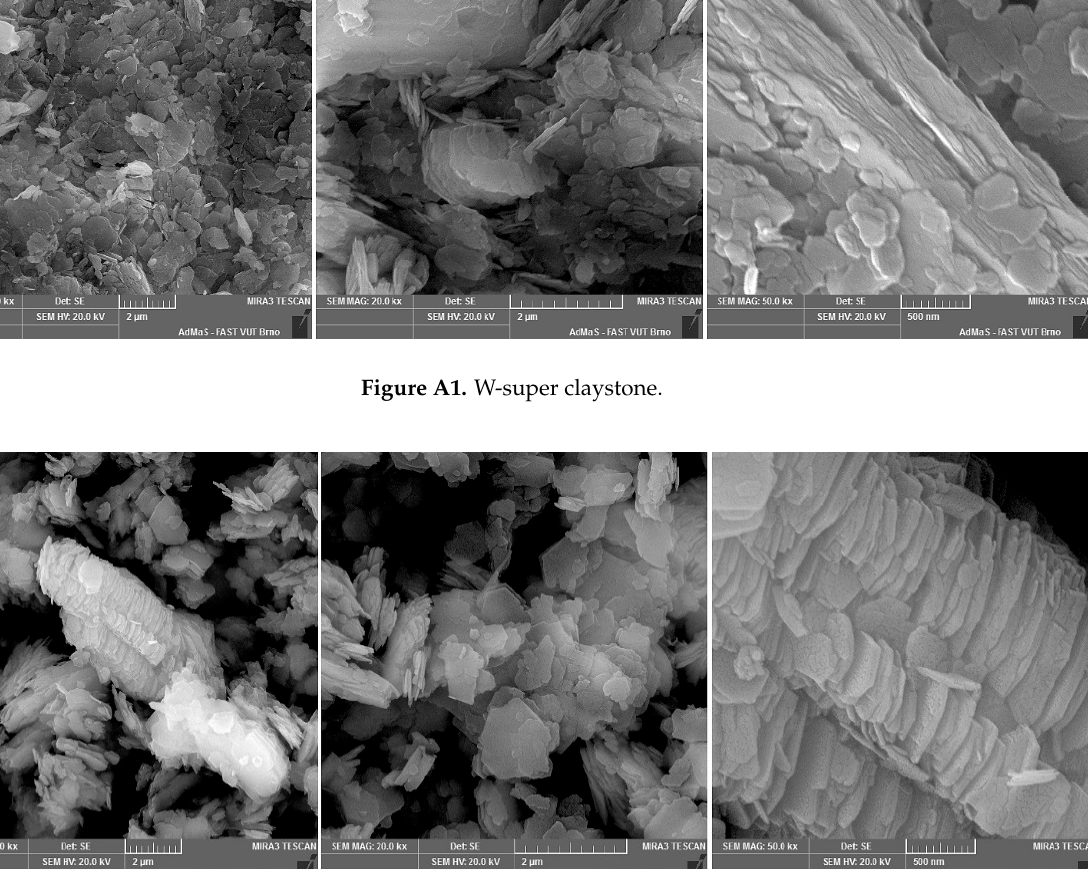
Figure A2. GP3 floated kaolin.